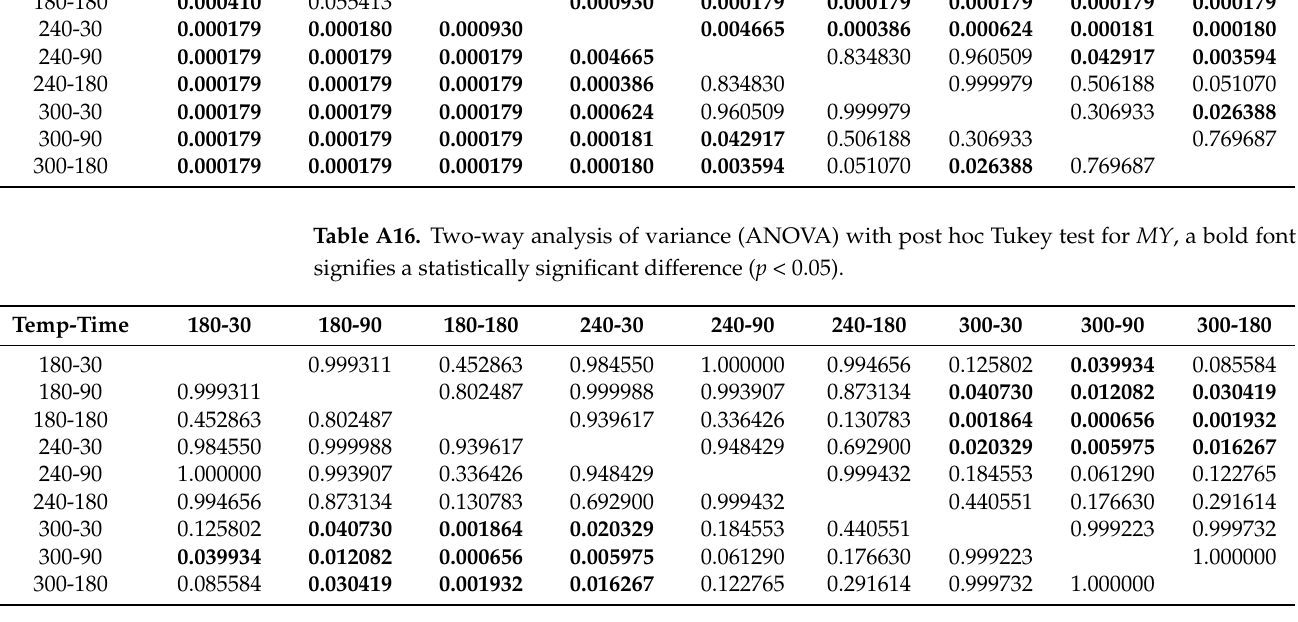
Table A17. Two-way analysis of variance (ANOVA) with post hoc Tukey test for EY , a bold font signifies a statistically significant difference ( p <